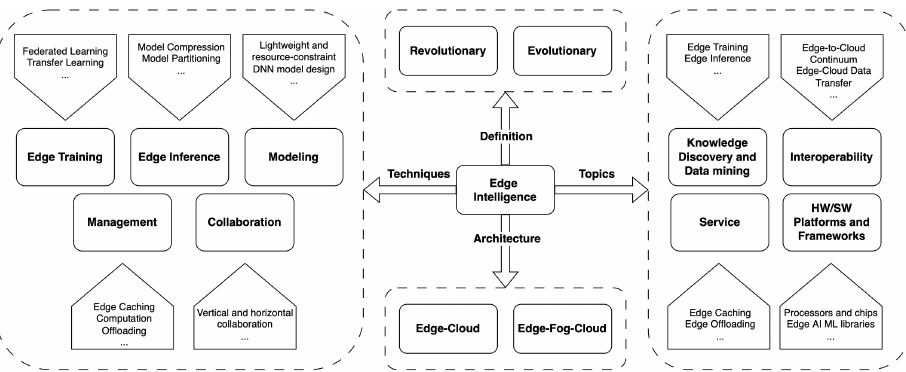
Figure 3. Directions and main findings (enclosed in dotted boxes) of the performed study on